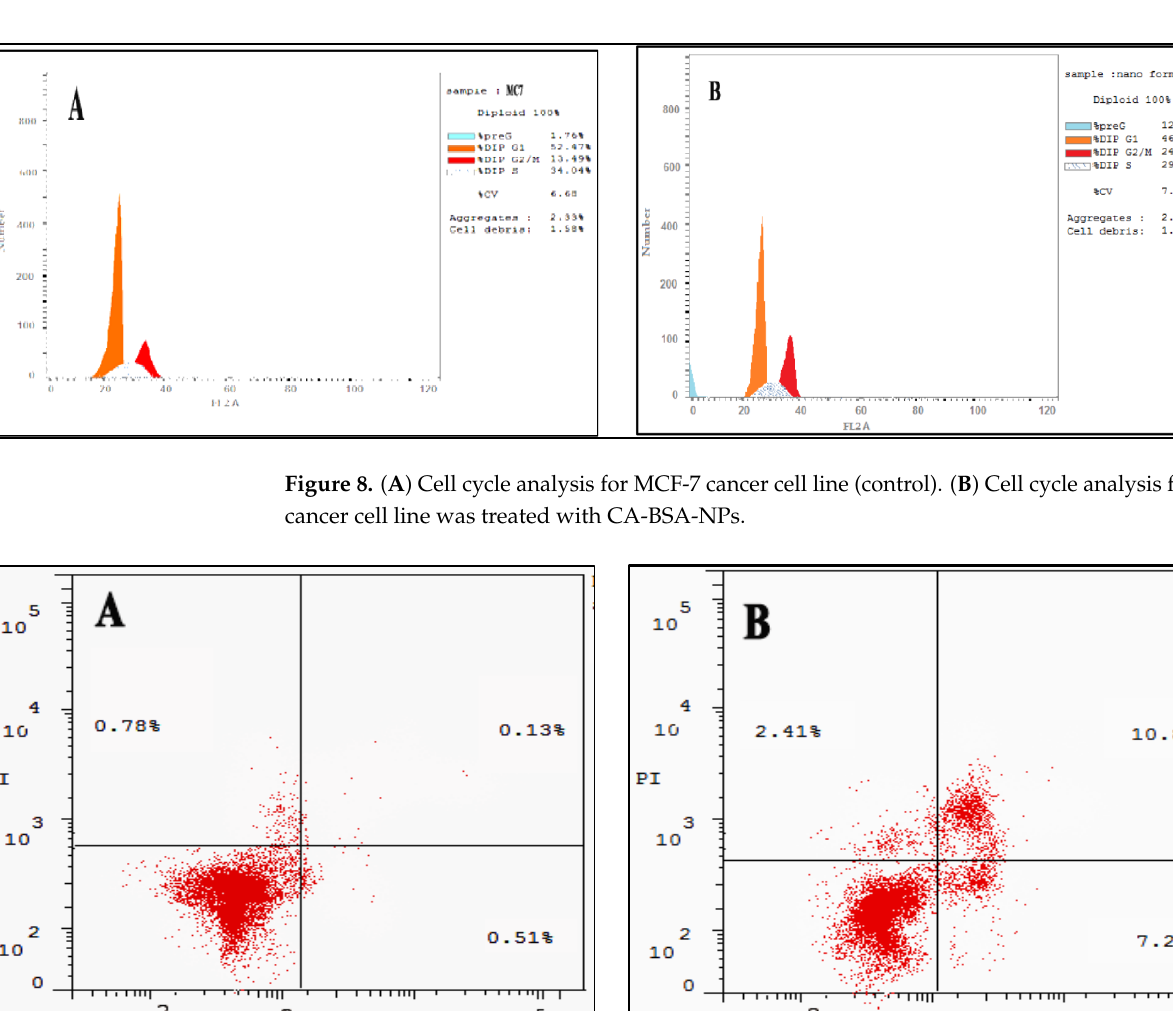
Figure 10. ( A ) Apoptosis analysis for MCF-7 (control); ( B ) apoptosis analysis for MCF-7 cancer cell line was treated with CA-BSA-NPs. 3.7. Gene Expression The current study evaluated the expression of BCL-2, COX-2, and GCLC genes in Caco-2 and MCF-7 cells (Figure 11A–C). Results revealed that in MCF-7, the treatment of CA-BSA-NPs (6.02 μg/mL) has significantly downregulated BCL-2 and COX-2 (FC = 0.469 and 0.29, respectively), while the expression level of GCLC was significantly in- creased (FC = 3.7) (Figure 11A,C). In Caco-2, the GCLC gene was also significantly upregulated (FC = 2.03), while the expression of BCL-2 and COX-2 were significantly decreased in CA-BSA-NPs-treated cells (FC = 0.73 and 0.37, respectively) (Figure 11B,C) compared to control cells ( p < 0.05 for each).